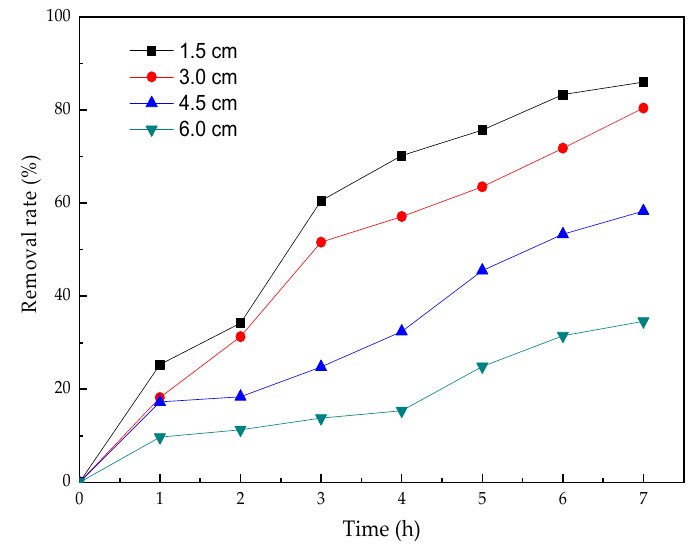
Figure 7. Effect of electrode spacing on the electrolysis of nicosulfuron.